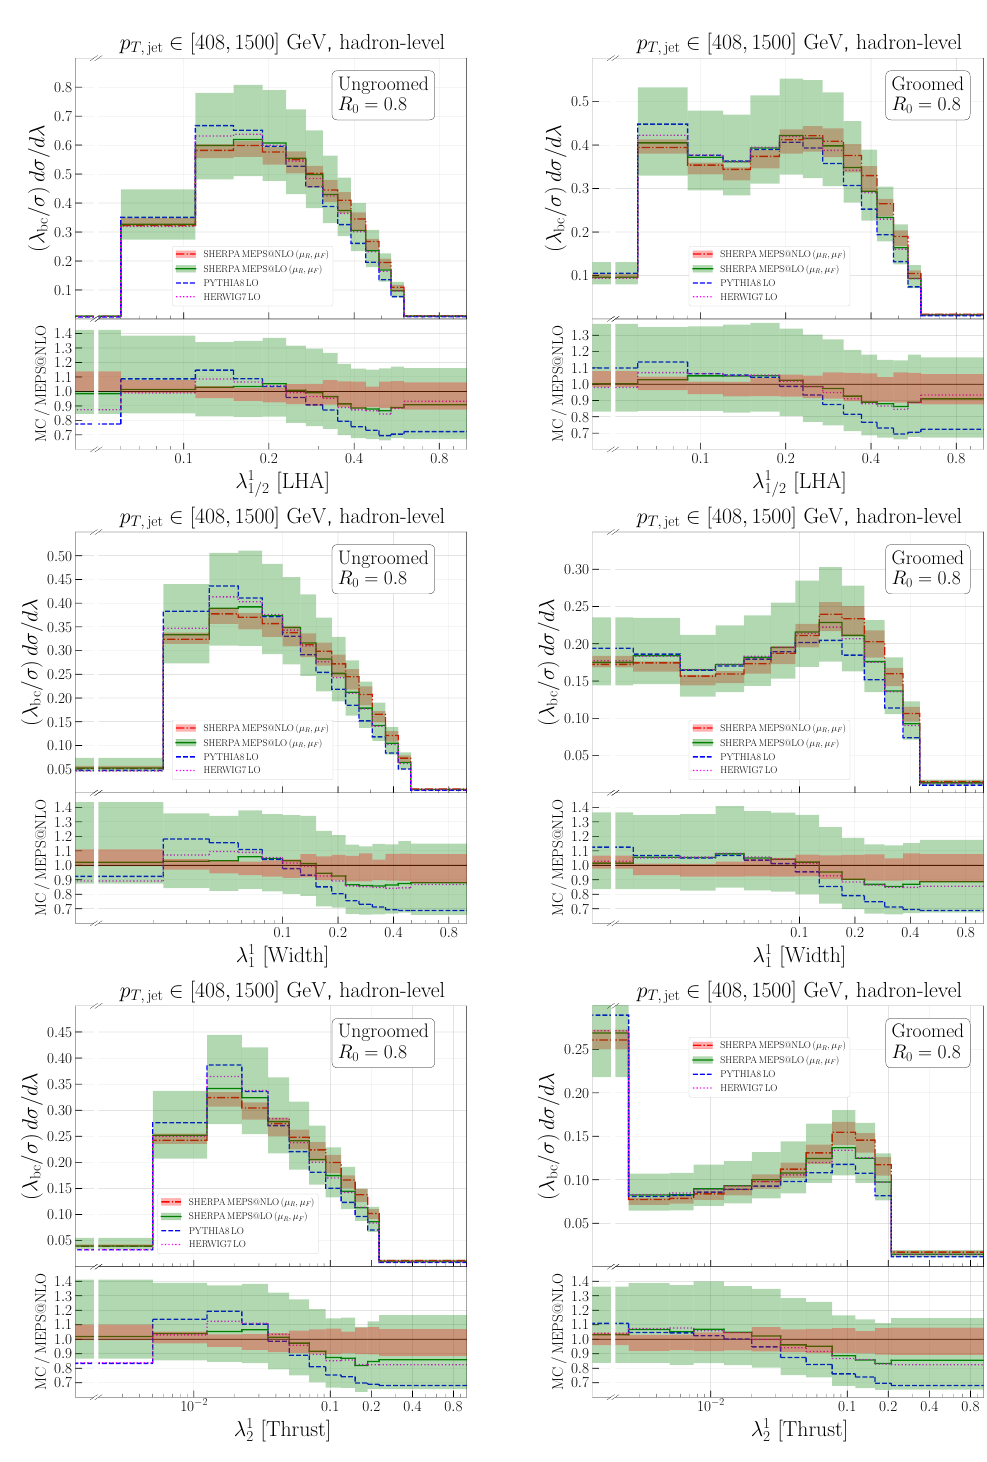
Figure 2 . Comparison of hadron-level predictions for ungroomed and groomed jet-angularities in Zj production from P YTHIA and H ERWIG (both based on the LO Zj matrix element), and MEPS@LO as well as MEPS@NLO results from S HERPA . Here p T, jet ∈ [408 , 1500] GeV and λ bc stands for the bin